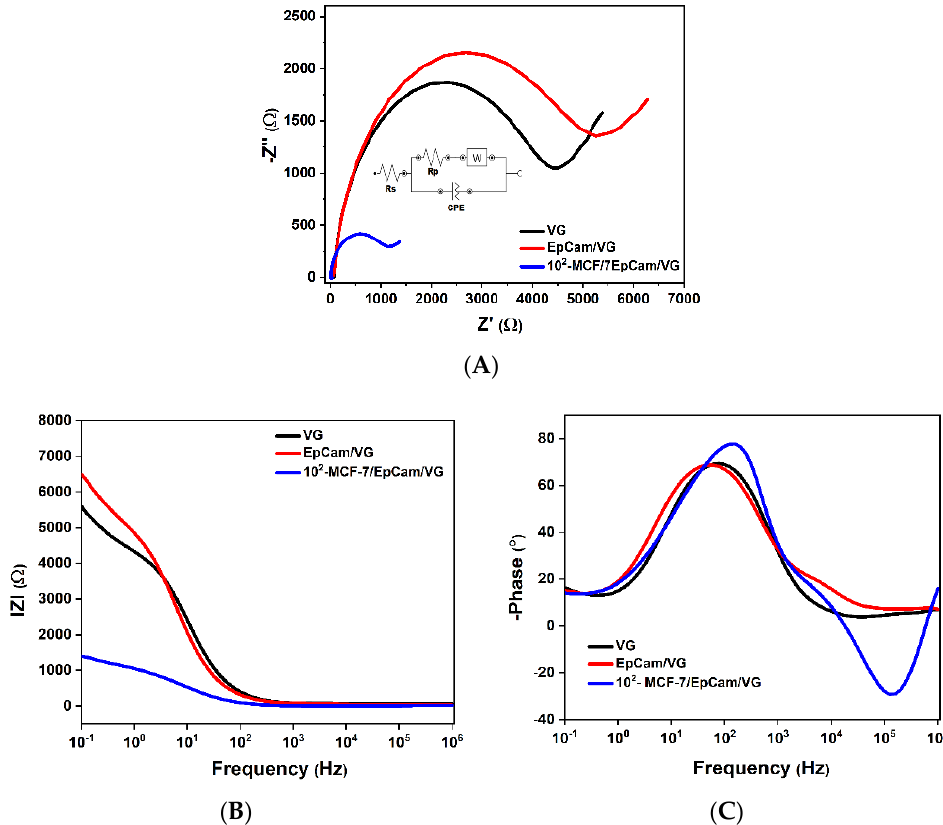
Figure 6. ( A ) Nyquist diagram; ( B , C ) Bode diagrams of VG: sensor blank, EpCam/VG and sensor after capturing 100 cell mL −1 concentration of MCF-7 cells from 0.1 to 10 6 Hz in PBS solution containing 1 mM [Fe (CN)6] 3−/4− and 0.1 M KCl. The impedance spectra (Nyquist plots) of the blank sensor (black curve), EpCAM/VG-based biosensor (red curve) and sensor after capturing SW403 cells (blue curve) are shown in Figure 7A. The impedance spectra are characterized by a semicircle portion at high frequencies, corresponding to a high charge-transfer resistance. A fundamental property of the electric double layer is its electric charge, which can be altered by various metabolic transformations. For this reason, investigations of electric charge can provide considerable information on the equilibrium existing within the membrane and between the membrane and its environment, both in physiological and non-physiological conditions.